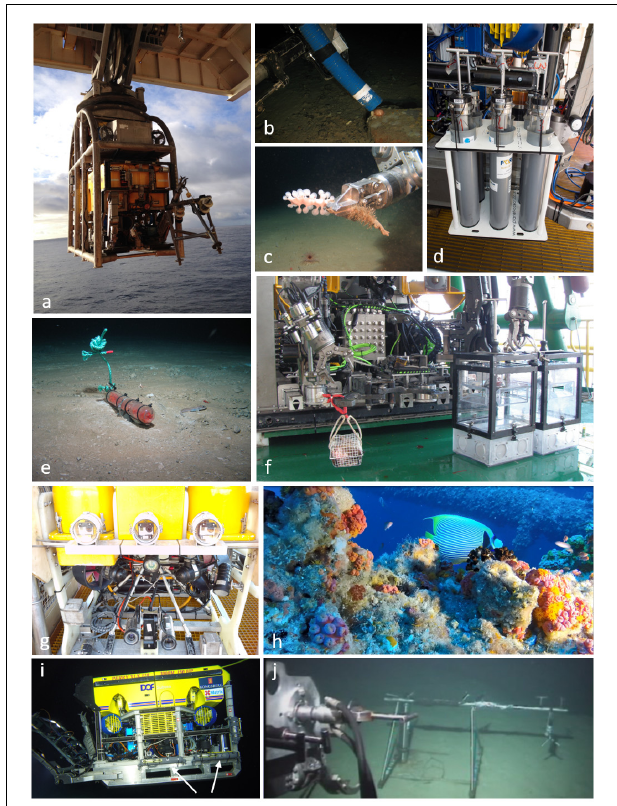
FIGURE 3 | Examples of how ROVs can be utilized to collect scientific information; (a) deployment of Oceaneering Magnum ROV holding a time-lapse camera system (to the right of the image) in 5-function manipulator arm, (b) modified zip pump for collecting fragile organisms (sea urchin pictured) suction tube attached to 5-function manipulator arm, (c) use of the 7-function ROV manipulator arm to collect specimens; (d) sediment core samplers, (e) deploying small traps to collect specimens (red scavenging isopods pictured), (f) bait cage and light traps to attract and capture organisms, (g) mounted stereo-video cameras to collect high definition imagery (h) . (i) DOF Subsea ROV fitted with Niskin Bottles (indicated by arrows) from the Sydney-Kormoran Project Expedition 2015 provided courtesy of Curtin University and WA Museum©. WA Museum (j) ROV recovery of a current meter from the seabed at 375 m, after Salim et al.